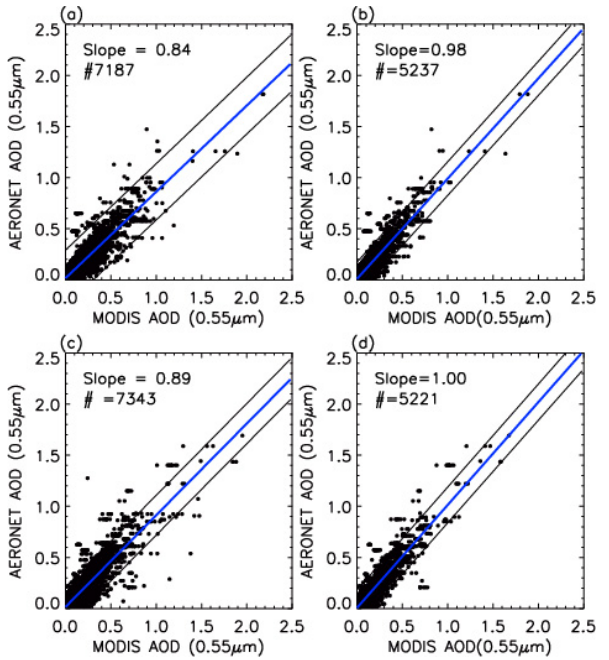
Fig. 5. Scatter plot of MODIS versus AERONET level 1.5 AOD at 0.55µm for 2009. The blue line is the linear regression line for all data and the black lines are the 1.0 standard deviation line of the blue line. (a) for the Terra MODIS C5 aerosol products. (b) for the newly generated Terra MODIS AOD. (c) for the Aqua MODIS C5 aerosol products. (d) for the newly generated Aqua MODIS AOD.